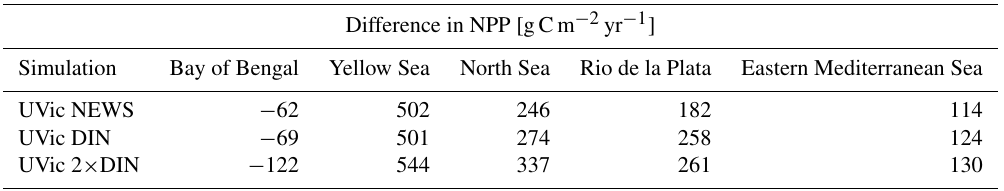
Figure 10. Total (water column and benthic) denitrification in the Bay of Bengal. (a) Total denitrification from CTR in nmolNm − 2 s − 1 . In the white areas total denitrification rates are smaller than 1nmolNm − 2 s − 1 . (b) Difference in denitrification between NEWS and CTR. (c) Difference in denitrification between DIN + DON and CTR. (d) Difference in denitrification between 2 × DIN and CTR. Table 5. Minimum and maximum values of NPP difference from CTR simulation as a supplement to Fig.